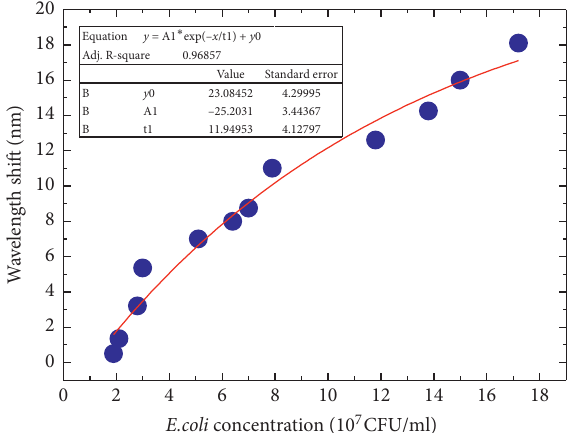
Figure 6: The behavior of prepared sensor for the detection of the E. coli . Experimental results were recorded after the culture me- dium was exposed at room temperature 1h